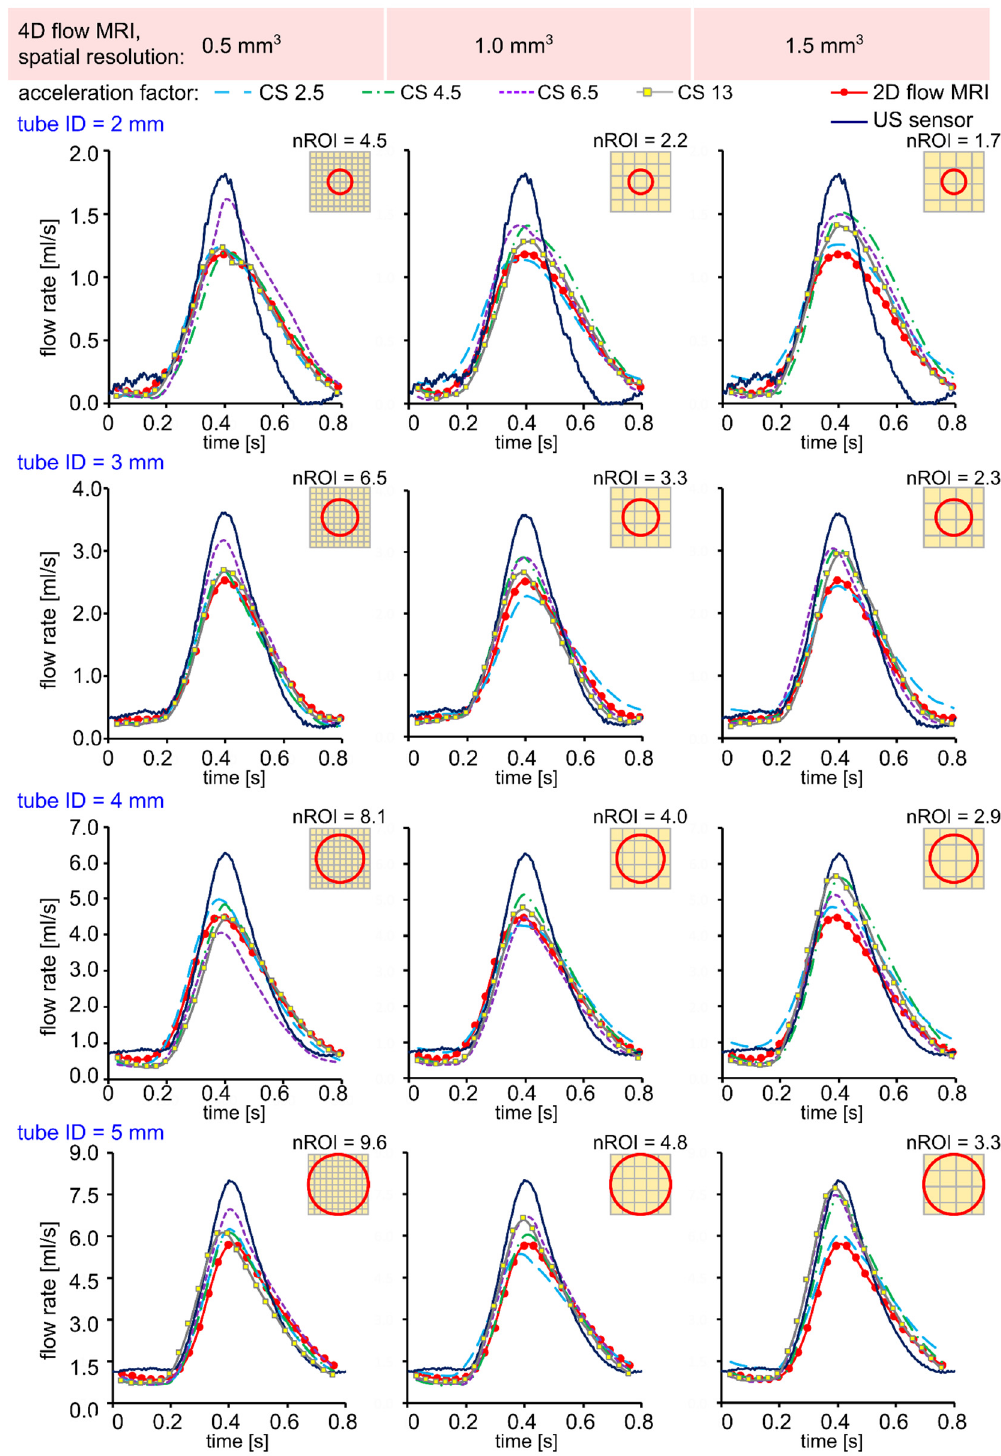
Figure 2. Time-resolved flow rate curves measured with US sensor, 2D flow MRI, and 4D flow MRI in silicone tubes with an inner diameter (ID) of 2, 3, 4, and 5 mm, respectively. The flow rates were calculated in three ROI A-C, as shown in Figure 1, and then averaged. Qualitatively, the peak flow values were overestimated for lower resolution 4D flow MRI data in comparison to 2D flow MRI.